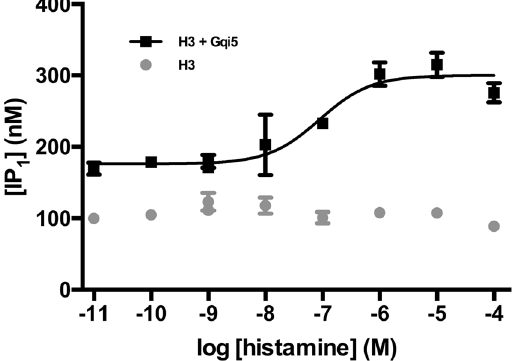
Figure 2. Assessment of histamine H 3 receptor G q -coupled pharmacological assay using the IP 1 accumulation assay measured by the HTRF IP-One assay. Concentration-dependent responses to histamine in H 3 receptor expressing tsA201 cells transfected with (black) and without (grey) Gqi5. Data are means ± S.D. of a single representative experiment performed in triplicate. Two additional experiments gave similar results.